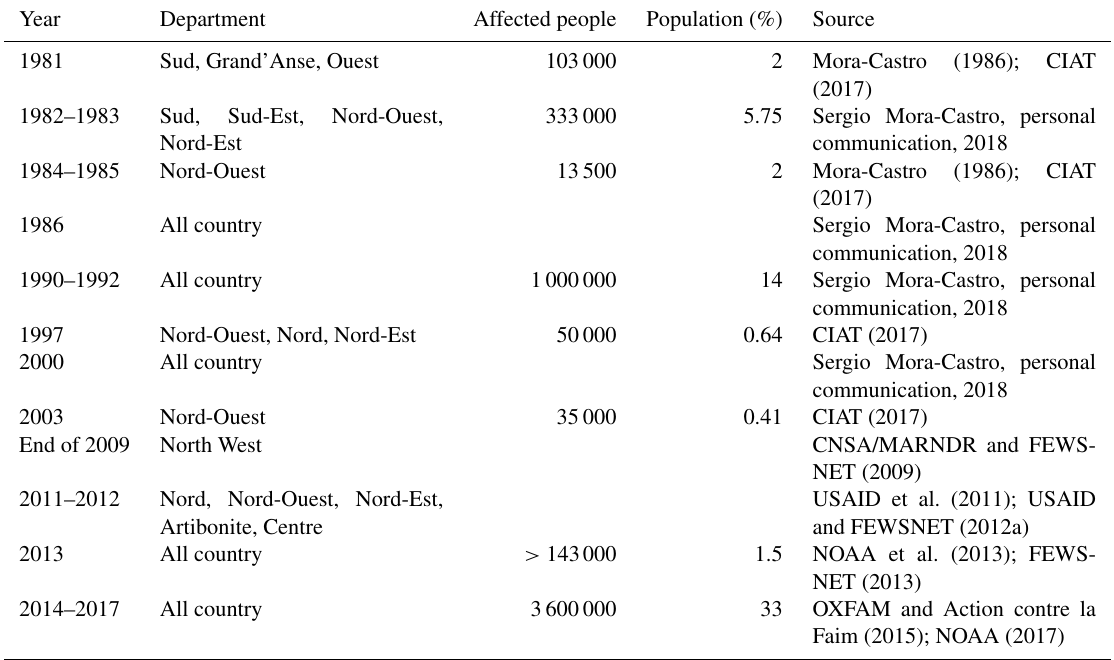
Table 7. Reported drought events in Haiti from 1980 to the present.